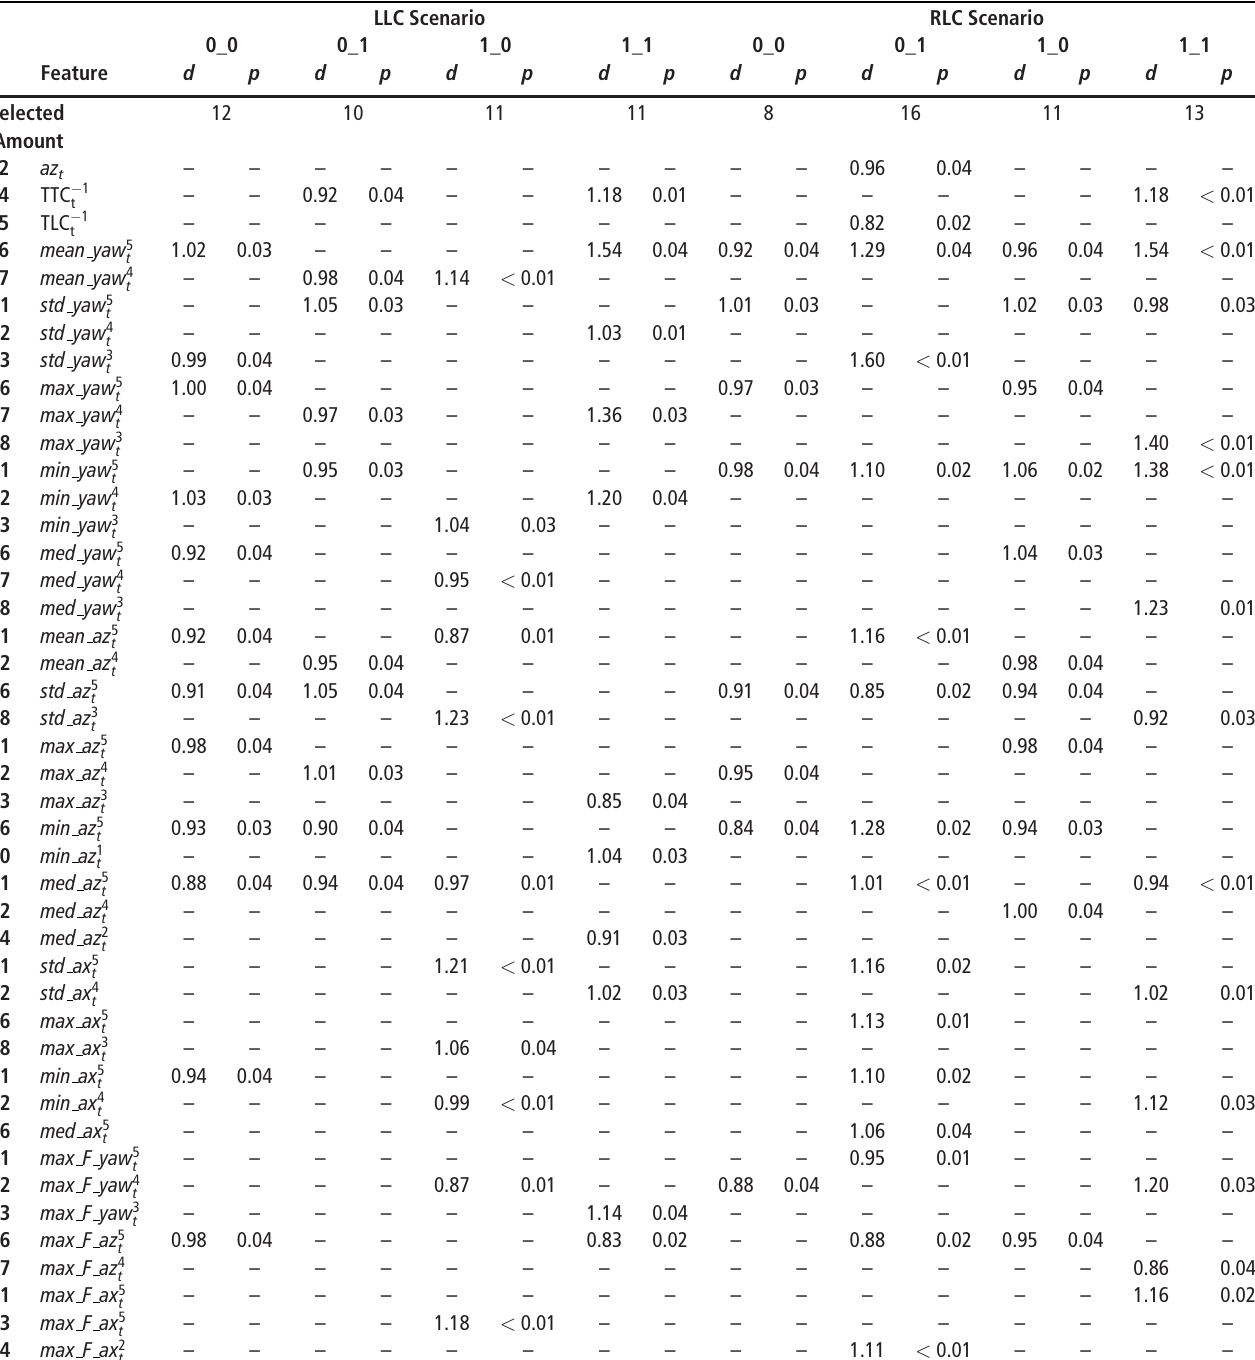
Table IV Final selected strong features for each LC